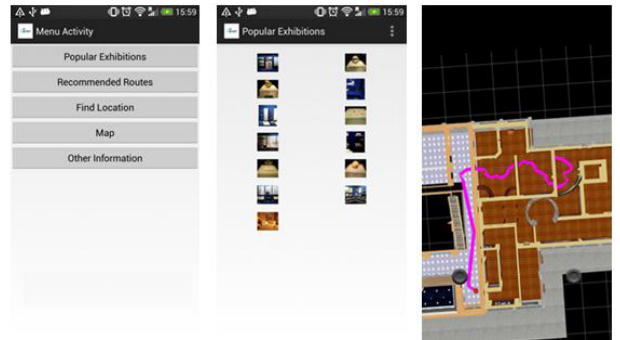
Figure 6. Left: main menu. Centre: popular exhibitions. Right: map